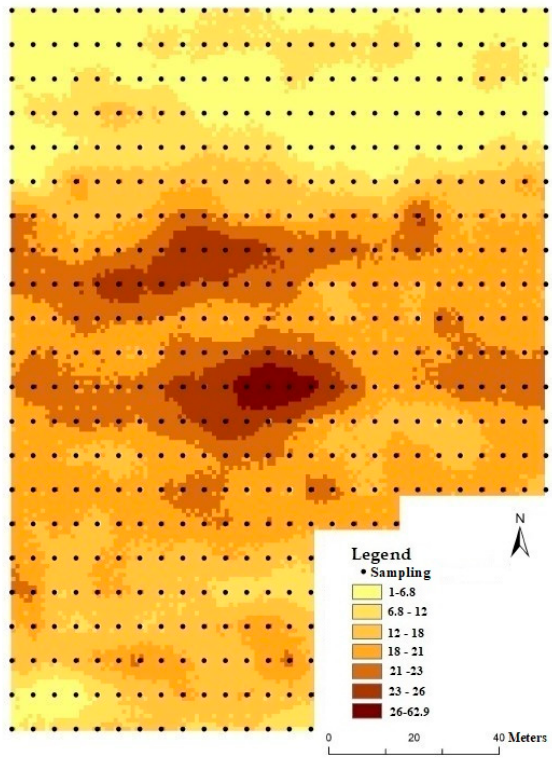
Figure 6. Grid map of VMC from 500 sequential Gaussian simulations (SGSs) in the tillering stage.